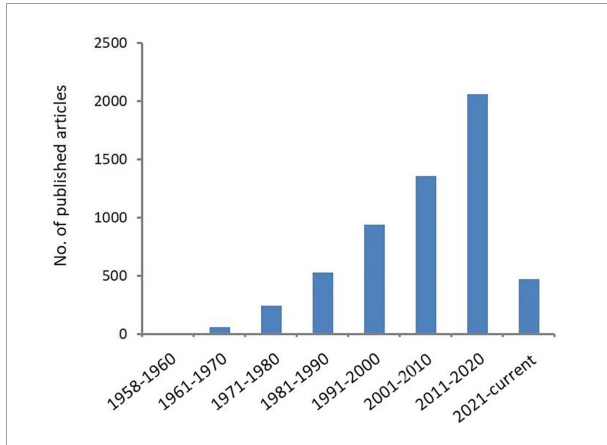
FIGURE1 Number of publications related to Acanthamoeba . Increasing scientific interest in the field of Acanthamoeba as determined by published articles cataloged in PubMed over